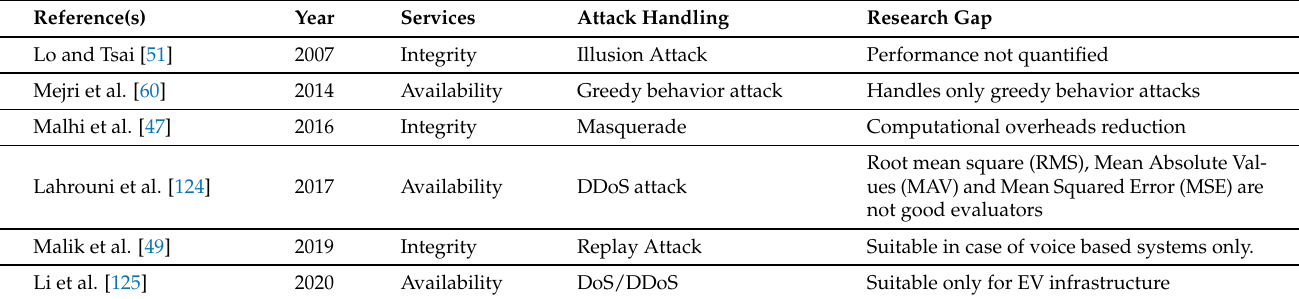
Table 8. List of hybrid solutions for